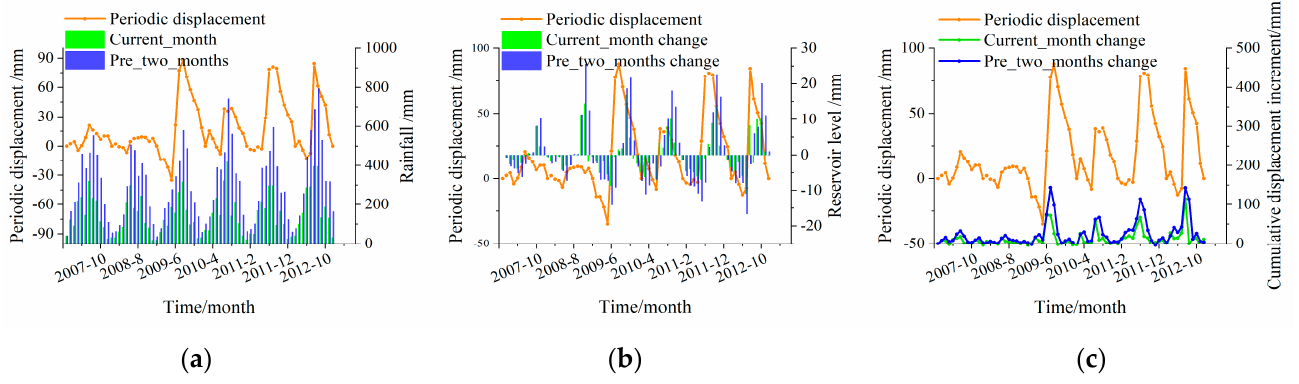
Figure 13. Relationship between influence factors and periodic term displacement. ( a ) Rainfall factor. ( b ) Reservoir water level change. ( c ) Cumulative displacement increment.